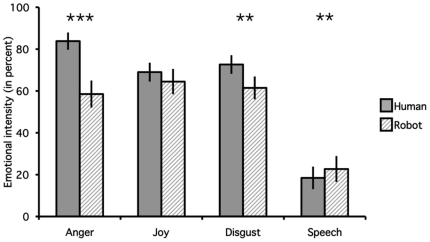
Emotional ratings.Mean (error bar: standard error of the mean SEM) of the percentage ratings of emotional intensity for the four types of gestures depicted by Human (plain color) and Robot (stripes) agents. Emotional ratings are significantly higher for the human in the case of Anger (***: p<0.001) and of Disgust (**: p<0.05) and for the robot in the Speech condition (**: p<0.05).